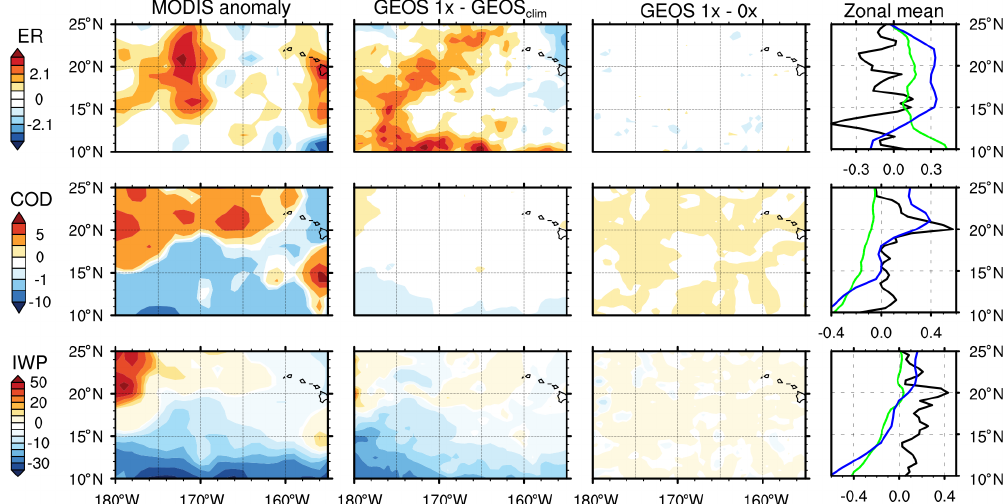
Figure 8. Ice cloud anomalies during JJA 2008 for (from top) R eff (µm, shown as ER), COD (–), and IWP (gm 2 ). Anomalies are shown (from left) for MODIS observations and for GEOS simulations calculated against GEOS CLIM and the zero-emissions scenario. The rightmost column shows normalized zonal mean anomalies for MODIS (blue) and GEOS against GEOS CLIM (green) and zero emissions (black).